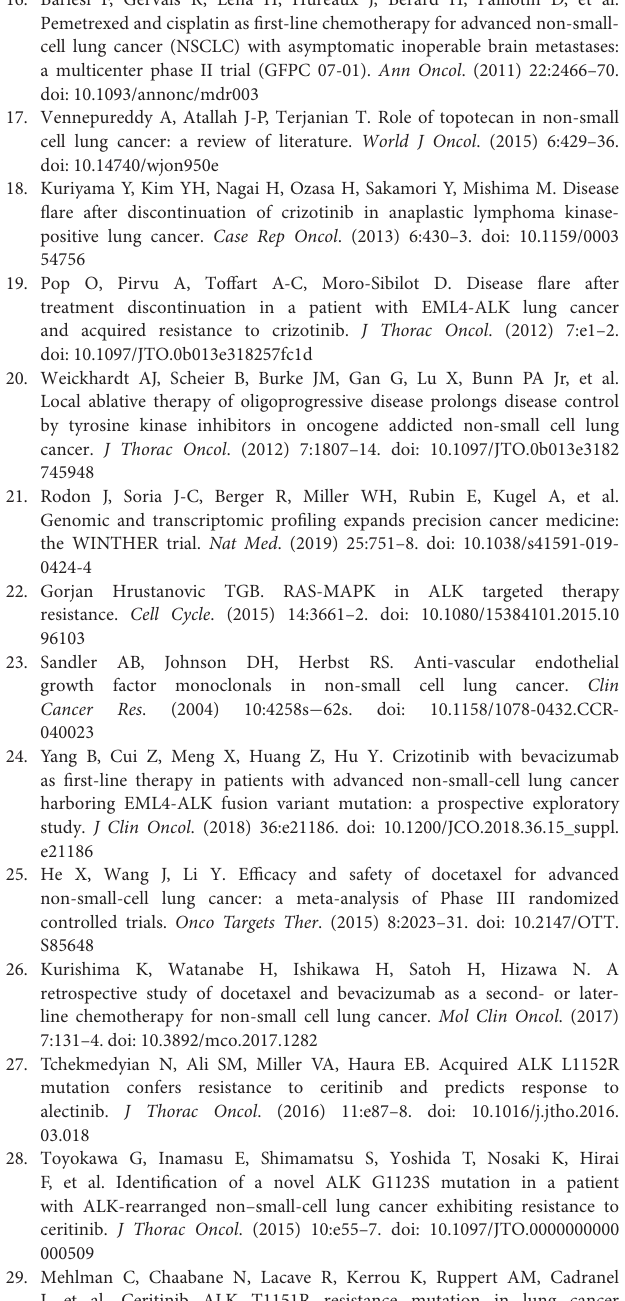
Supplementary Table 1 | Oncobox balanced efficiency scores and pathway activation